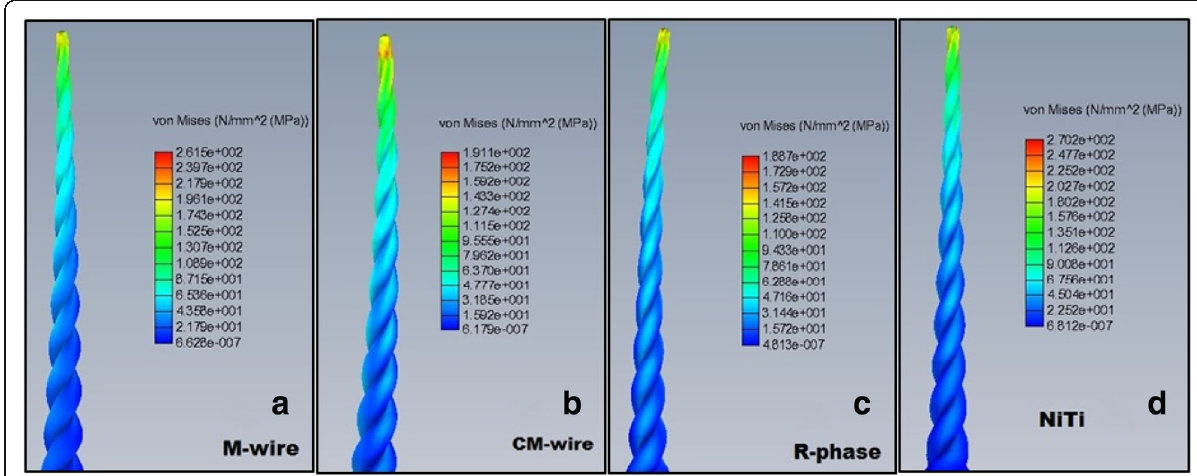
Fig. 3 a – d Stress distribution during torsion of CM-wire, M-wire, R-phase, and NiTi FE models,